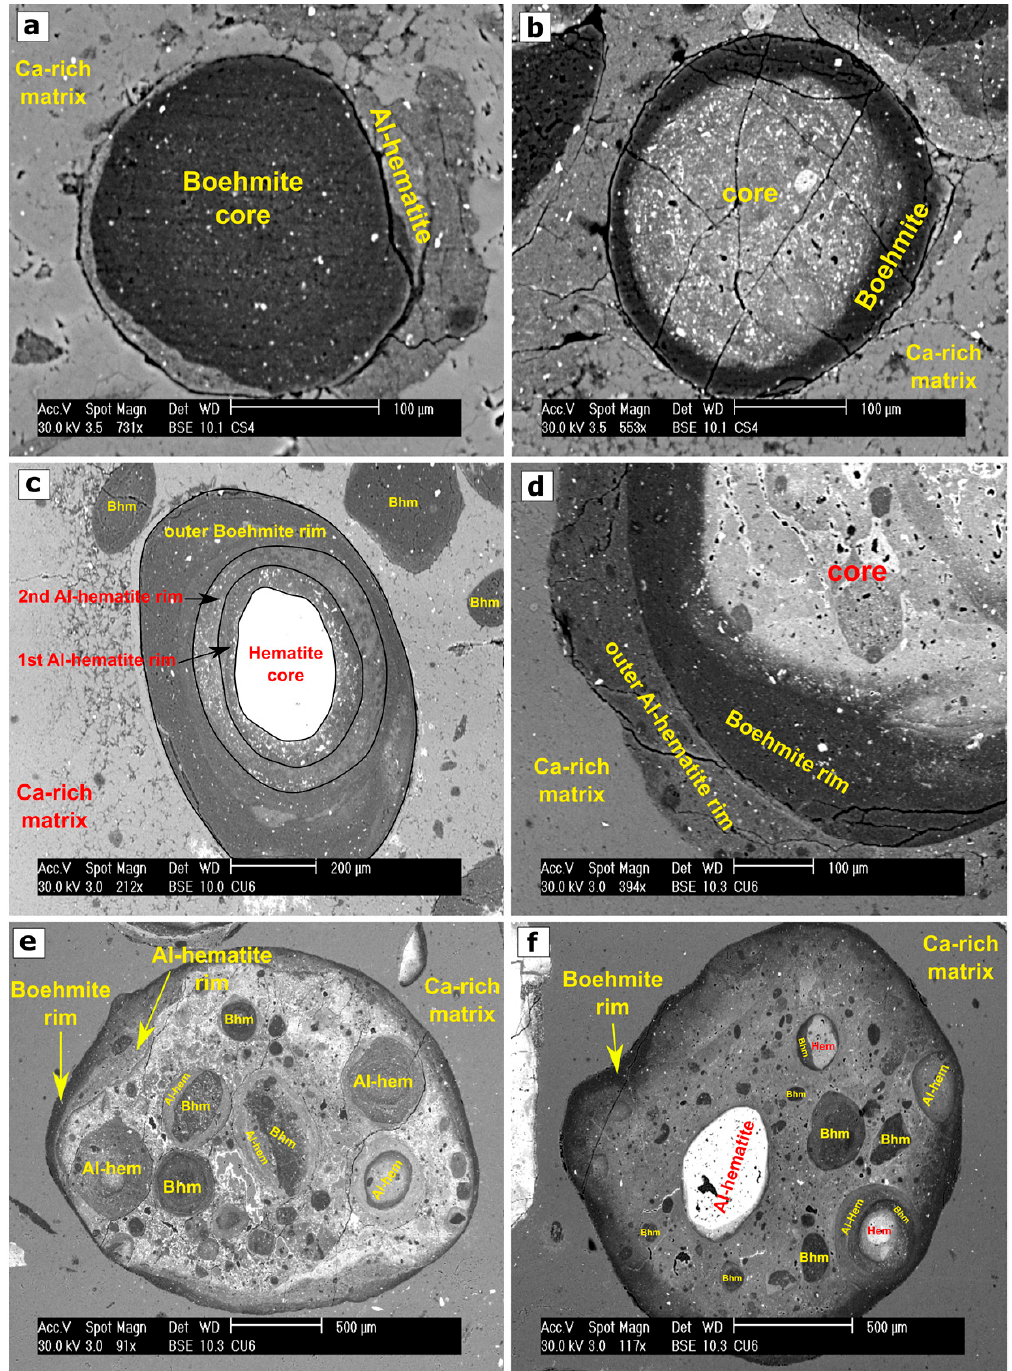
Figure 4. SEM-EDS images showing the typical texture of studied bauxites: ( a ) boehmite core surrounded by a thin layer of Al-hematite in a Ca-rich matrix; ( b ) Al-hematite core surrounded by a boehmite rim; ( c ) large Al-hematite core surrounded by several layers of different composition; ( d ) multi-mineral core with two layers of boehmite and Al-hematite in a Ca-rich matrix; ( e , f ) two larger chaotic structures incorporating several aggregates and ooids in a Ca-rich matrix. Larger structures incorporating numerous ooids, which are likely the result of re- deposition of pre-existing bauxites, were observed mainly surrounded by an outer rim of boehmite (Figure 4e,f). Accessory minerals, such as zircon and monazite, have been